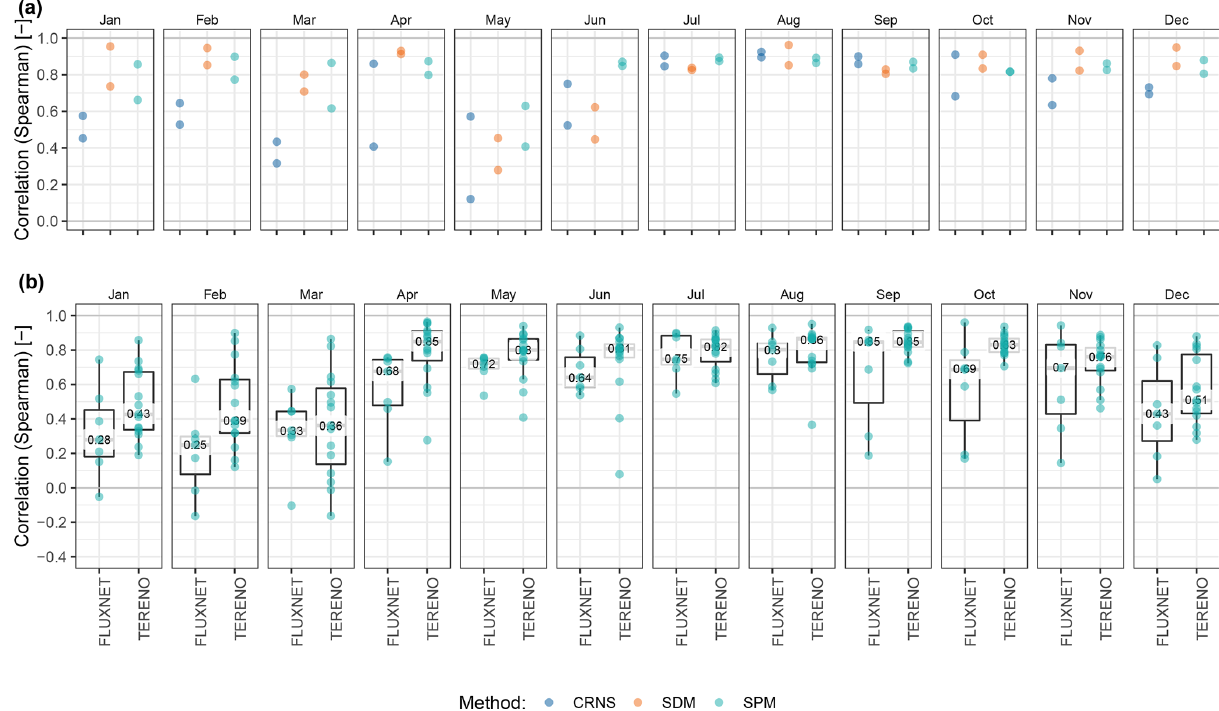
Figure A2. Spearman correlation coefficients of simulated soil moisture by mHM in the GDM-v2-2021 setup versus observed de- seasonalized soil moisture anomalies for each month; this serves as a supplement to Fig. 5 by (a) comparing the locations Hohes Holz and Am Grossen Bruch equipped with CRNS, SDM, and SPM soil moisture measurements, and (b) comparing FLUXNET ( n = 7) and TERENO ( n = 20) SPM